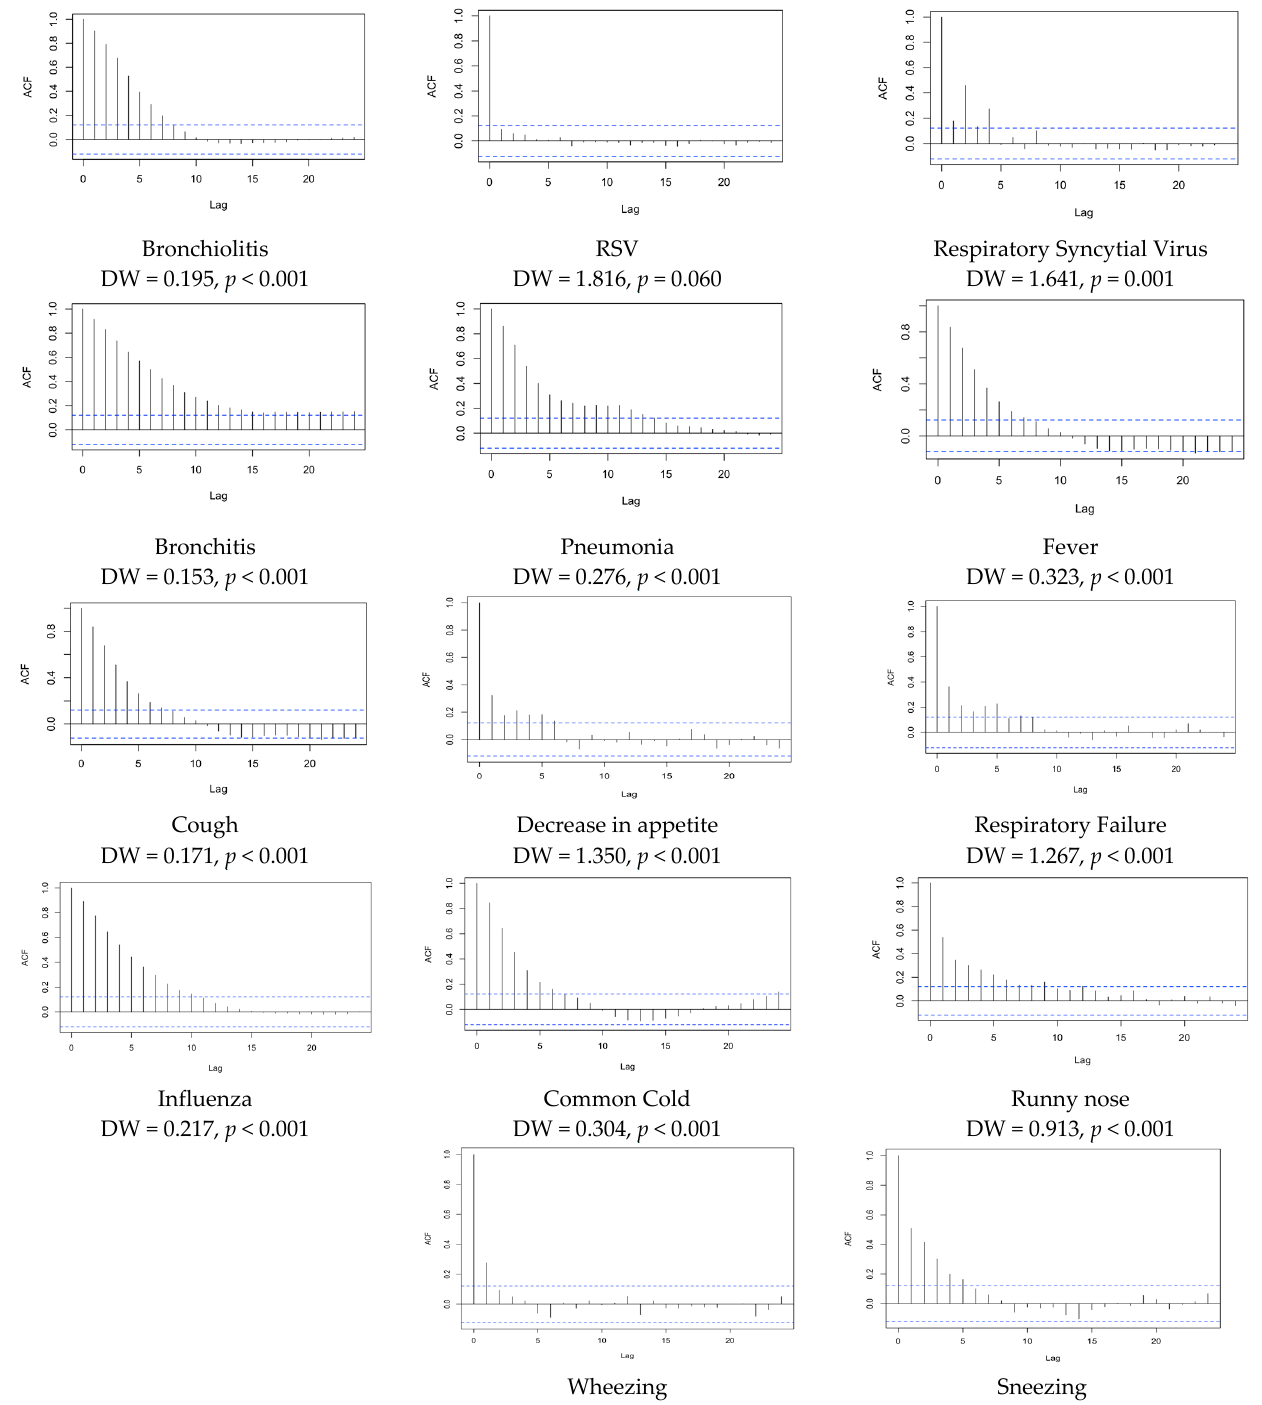
Figure A5 . Autocorrelation plots for hit searches during the assessed timeframe (2017–2022). Note: ACF = autocorrelation factor; DW = Durbin Watson coefficient. Values of DW coefficient > 2.0 rule out annual cyclical pattern.